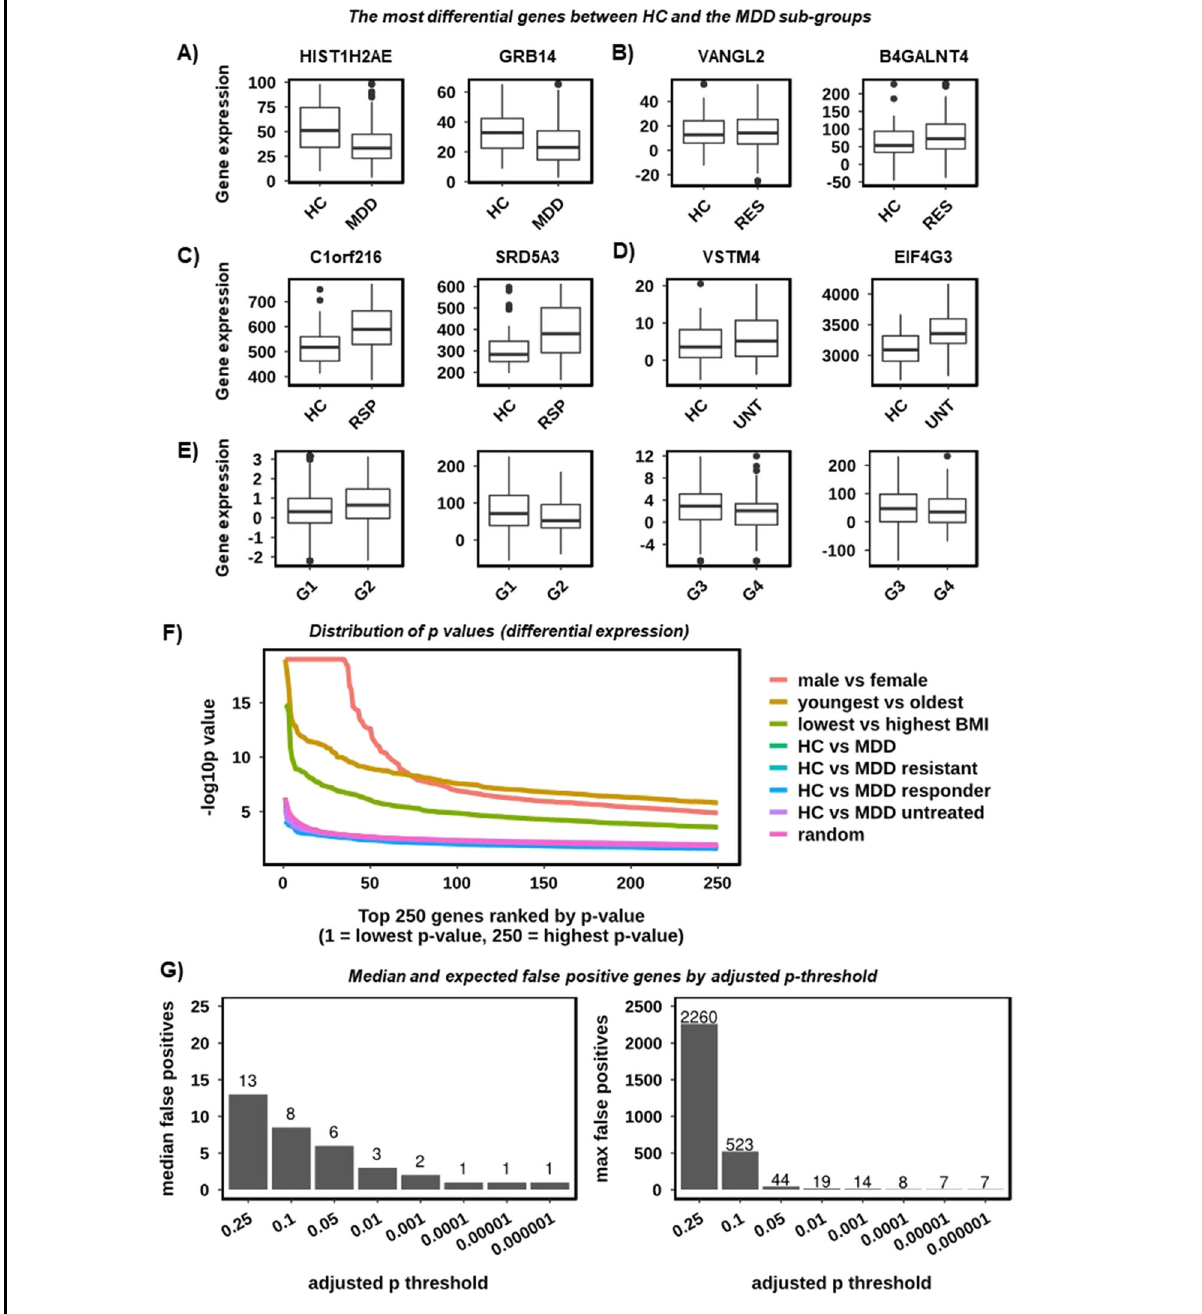
Fig. 2 There is no evidence for a classical differential expression signature between HC and MDD in PBMCs. A Gene expression boxplots highlighting the most signi fi cantly different genes between HC and MDD. Sample groups are shown on the x -axis and gene expression values (DESeq2 normalised counts) on the y -axis. B As A however for HC vs the MDD treatment-resistant group. C As A however for HC vs the MDD treatment-responsive group. D As A however for HC vs the MDD untreated group. E As A however for the two most signi fi cant genes from each of two comparisons of randomised cases and controls. Randomised groups are labelled G1 – G4. F Distribution of differential expression p -values highlighting the consistency between HC vs MDD and randomised cases and controls. The 250 most signi fi cant genes for each comparison are shown on the x -axis (ranked from lowest to highest) and the p value (as − log10) on the y -axis. Lines are given for the three confounding variables Gender ( ‘ male vs female ’ ), Age ( ‘ youngest vs oldest ’ ), BMI ( ‘ lowest vs highest ’ ), HC vs the four MDD types (MDD, MDD treatment-resistant, MDD treatment-responsive and MDD untreated) and for the average of 50 comparisons of randomised cases and controls ( ‘ random ’ ). G Bar charts highlighting the number of differentially expressed genes that were expected to be false positives by adjusted p threshold, based on 50 iterations of randomised cases and controls. The adjusted p threshold is given on the x -axis and the median (left) and maximum (right) number of expected false positives on the y